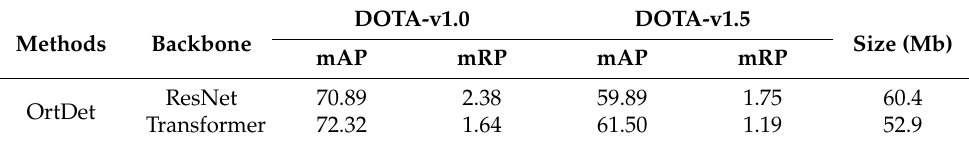
Table 6. Performance comparisons of the backbone on OrtDet.